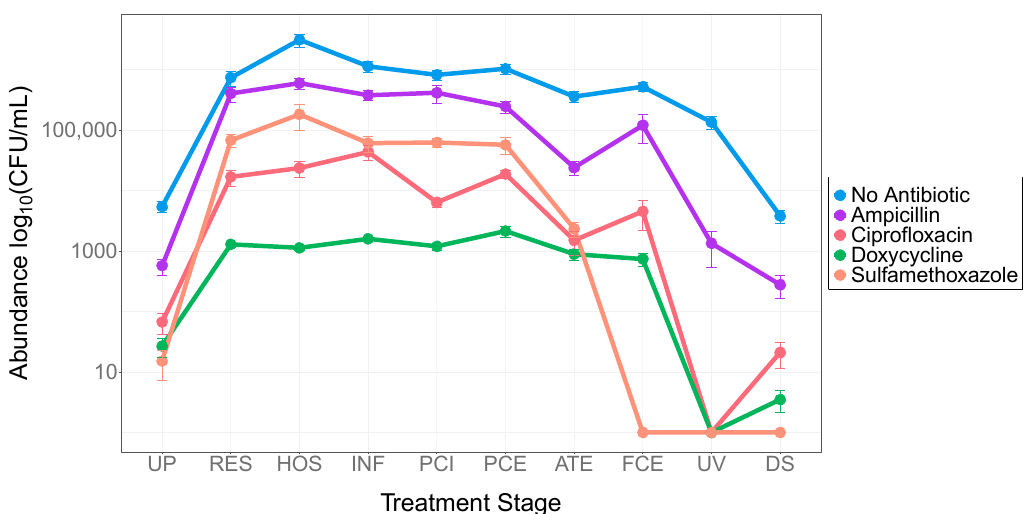
Figure 2. Abundance of microbial colonies grown on the four antibiotics and a control at each stage of the treatment process. Total heterotrophic and resistant microbial concentrations saw significant reductions from the initial raw sewage to the final UV-treated effluent. Error bars indicate the standard error of the mean for each antibiotic treatment at each site. UP, upstream; RES, residential sewage; HOS, hospital sewage; INF, sewage influent; PCI, primary clarification influent; PCE, primary clarification effluent; ATE, aeration tank effluent; FCE, final clarification effluent; UV, UV treated effluent; DS, downstream.